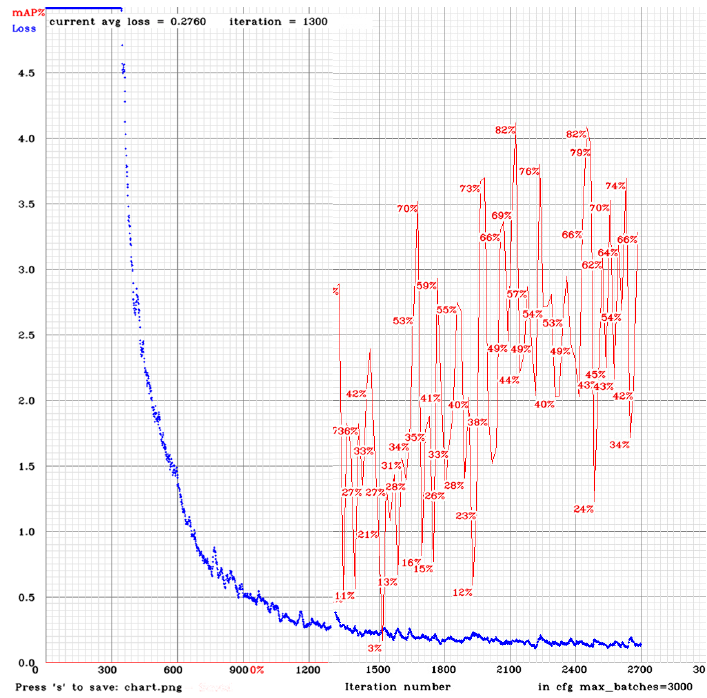
Figure 12. The mAP plotted over average loss and number of iterations.